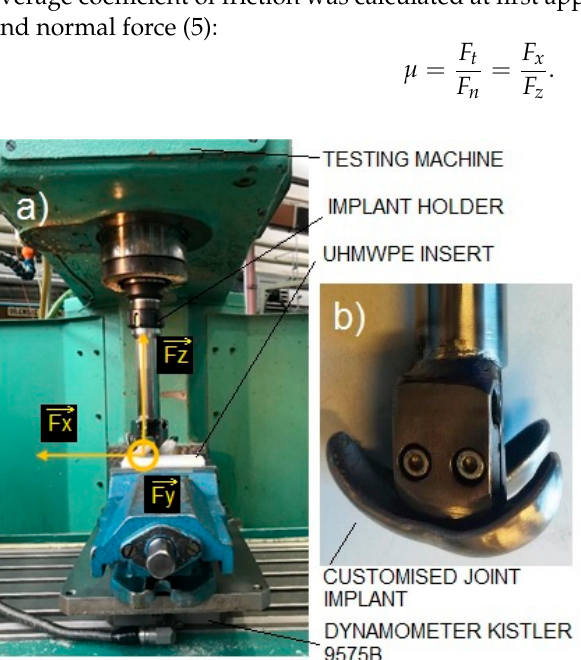
Figure 9. The experimental setup for testing the friction. ( a ) the machine FV 25CNC/Heidenhain iTNC 530, the dynamometer Kistler 9575B, and the sample clamped into vice, ( b ) customised joint implant in the mechanical holder.